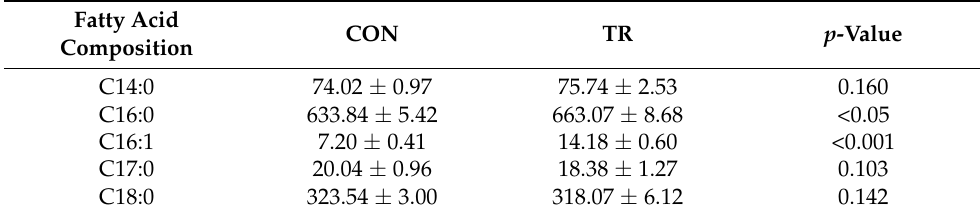
Table 3. Fatty acid profile (mg/100 g muscle) of Longissimus lumborum muscle of Charolais beef cattle fed a control diet (CON) and a diet supplemented with omega-3 lipid supplement